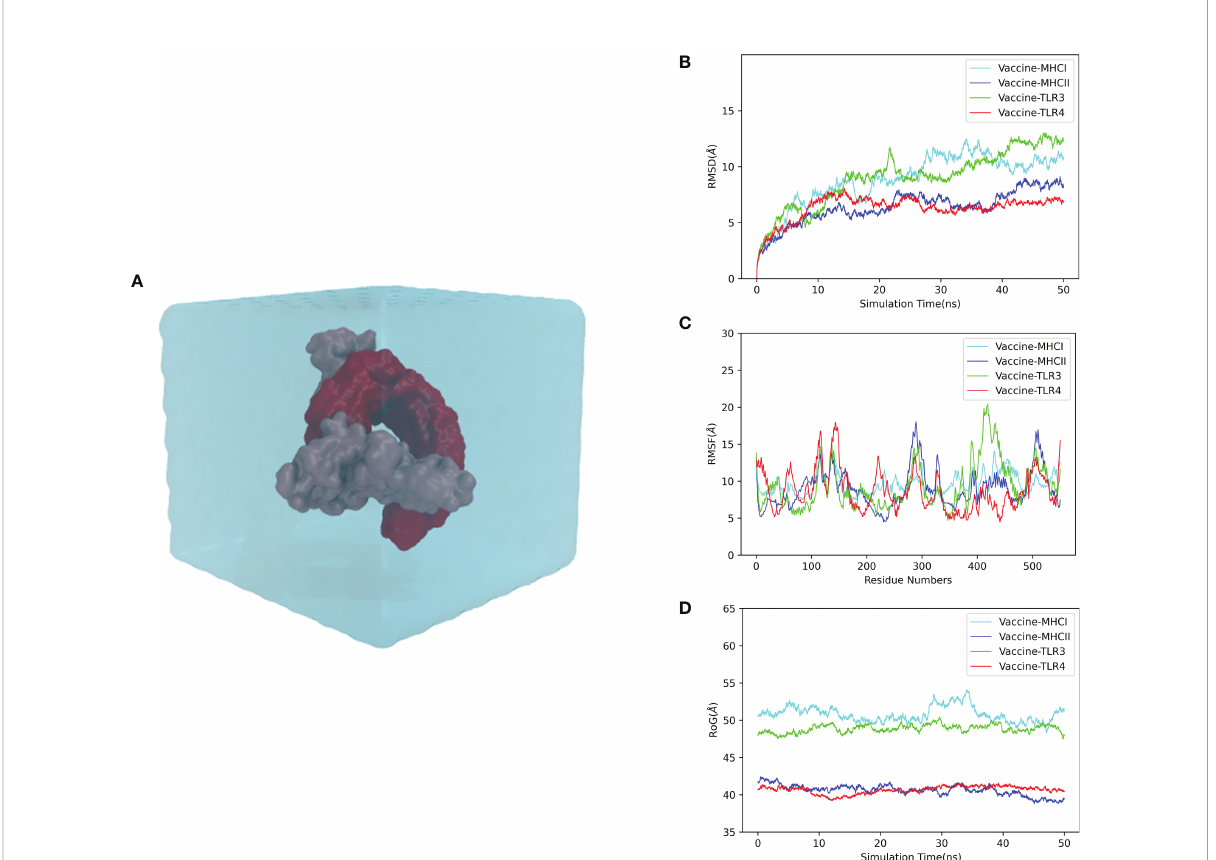
FIGURE 6 Molecular dynamics simulation of the CVB vaccine – immune receptor complex at 50 ns. (A) Molecular dynamics system (prepared for the simulation); (B) RMSD (root mean square deviation) of the docked complex re fl ects the stability between the vaccine. (C) RMSF (root mean square fl uctuation) re fl ects the fl exibility and fl uctuation of the amino-acid residues in the side chain of docked complexes. (D) Time evolution of the radius of gyration (rRyr) during 50 ns of MD